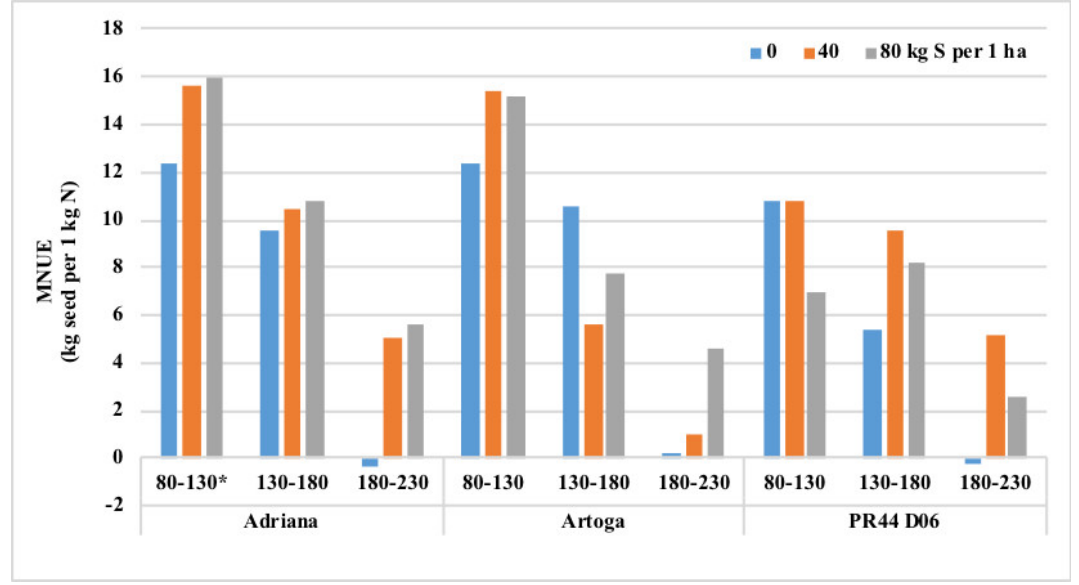
Figure 5. Marginal efficiency of N fertilization in winter oilseed rape cultivars in response to different S rates, across years. * N rate intervals.